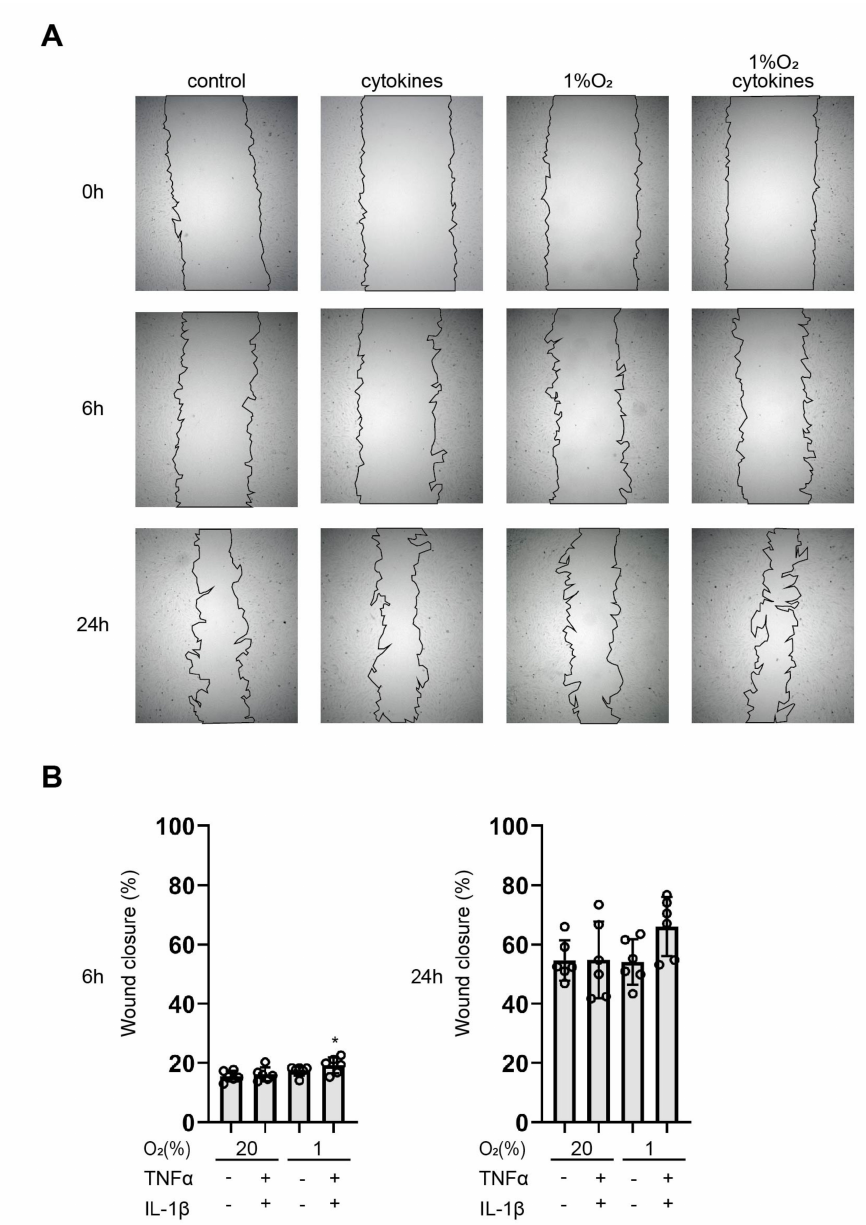
Figure 7. Cytokines facilitate wound healing. Confluent monolayers of EM-E6/E7/TERT cells were wounded with a uniform scratch, washed to remove cell debris, and cultured for 24 h under 1% or 20% O 2 conditions in the absence or presence of TNF α (500 ng/mL) and IL-1 β (100 ng/mL). ( A ) Phase contrast images of cell cultures after 0 h (upper 4 panels), 6 h (middle 4 panels), and 24 h (lower 4 panels) are presented. ( B ) Measurements of colonized areas. “Percentage wound closure” was defined as: (area at time 0—area at each time/area at time 0) × 100. Data represent the mean ± SD ( n = 6). * p < 0.05 compared to the